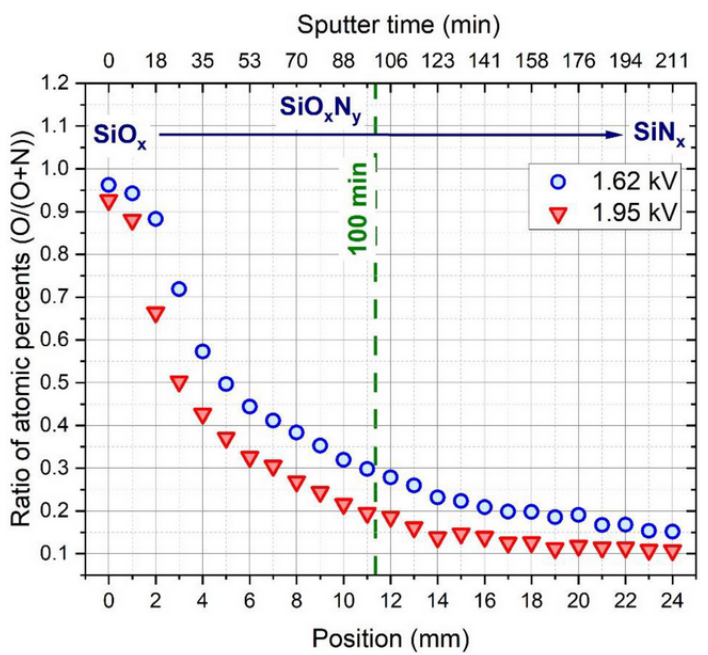
Figure 16. Atomic concentrations (O/O+N) measured by SEM EDS along the micro-combinatorial SiON samples deposited at 1.62 and 1.95 kV. A continuous decrease in the O concentration was observed, resulting in SiO x → SiO x N y → SiN x transitions. Reproduced with permission from [76]. Copyright © 2022, MDPI, Basel, Switzerland.